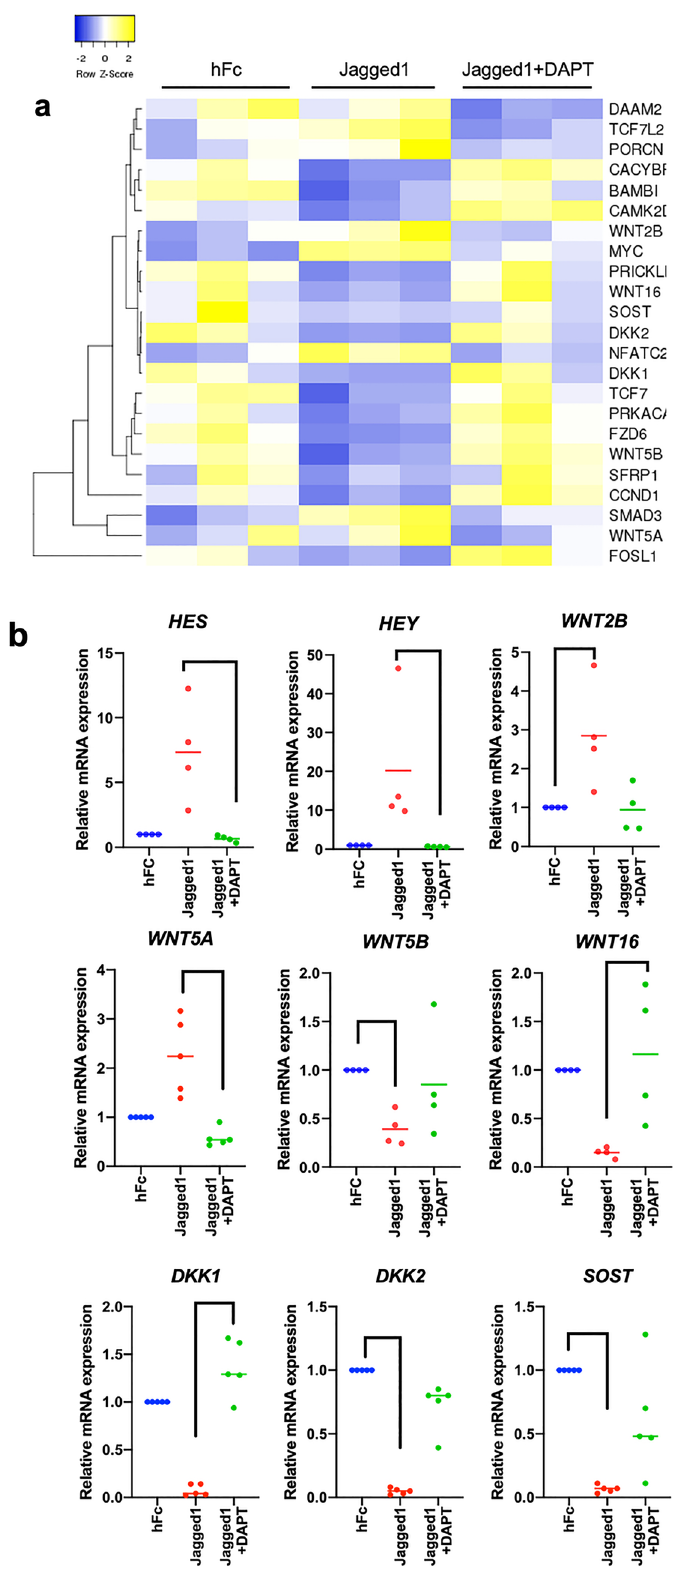
Figure 2. Notch regulates Wnt-related gene expression. ( a ) Heatmap demonstrating the significantly differential expression of Wnt-related genes in the Jagged1-treated condition. ( b ) The differential gene expression of selected genes in Jagged1-treated hDPSCs was confirmed using real-time polymerase chain reaction. Bars indicate a significant difference between groups ( p <